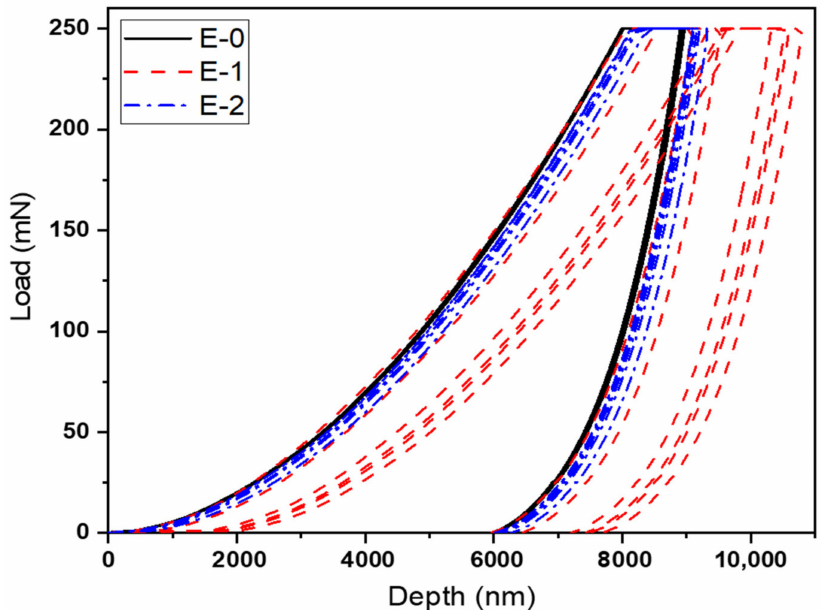
Figure 6. Load vs. depth curve for coatings prepared with PA-450 at different percentages.